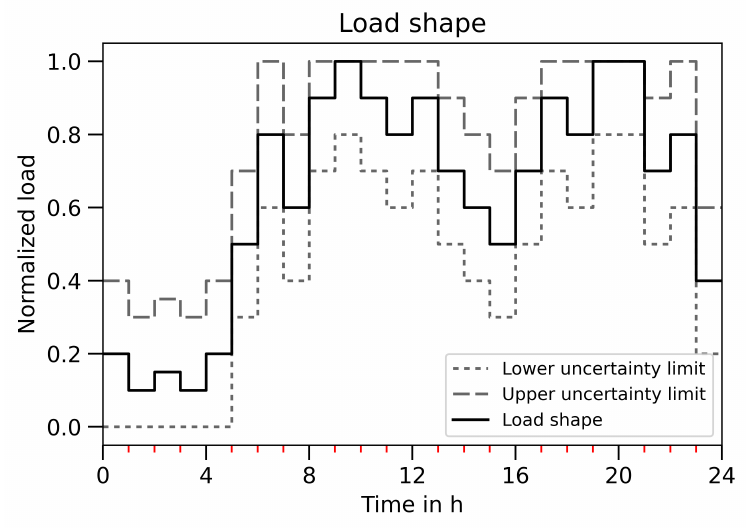
Figure 12. Consumers’ load shapes with the uncertainty range of